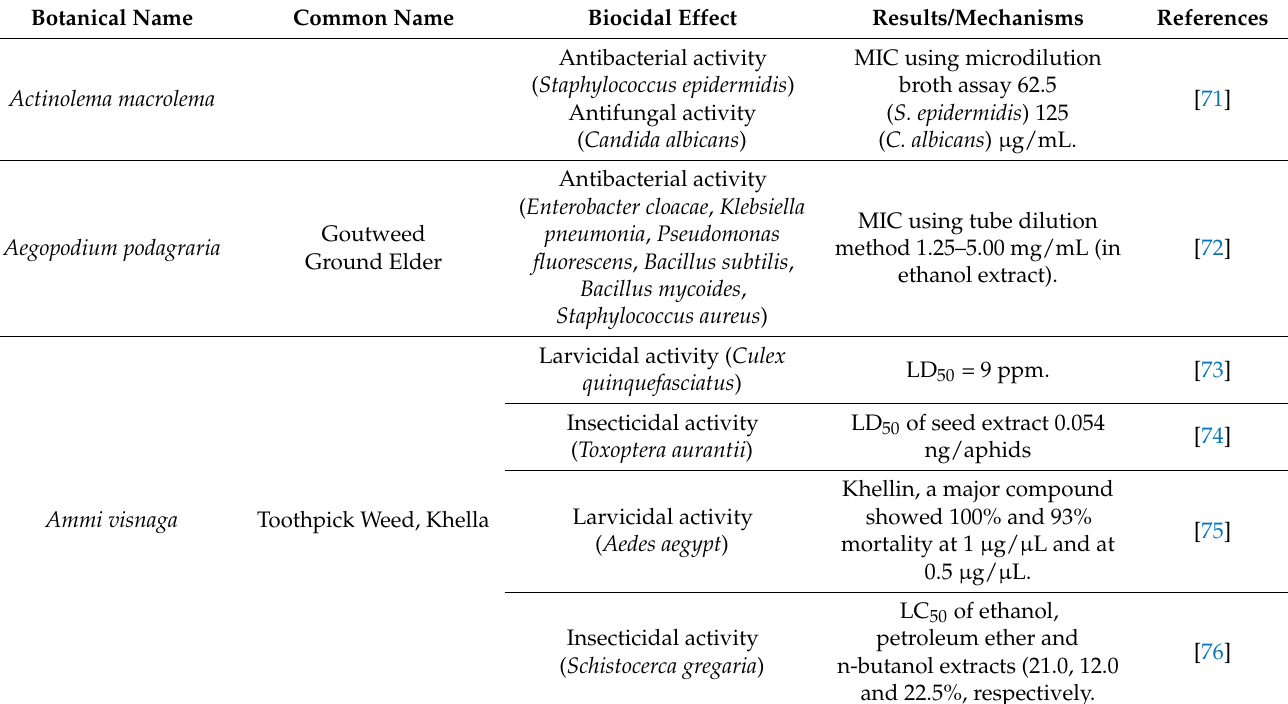
Table 2. Phytochemical constituents of Apiaceae plant